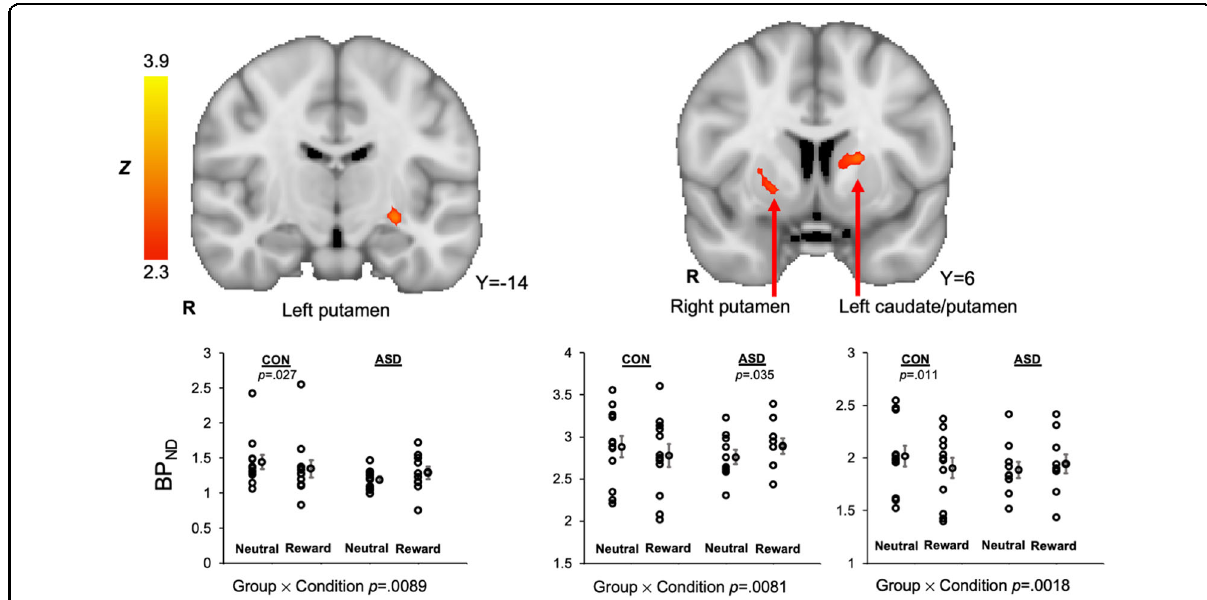
Fig. 2 Striatal clusters that showed ASD > control [ 11 C]raclopride BP ND (reward> neutral), signifying decreased phasic release of dopamine to rewards in the ASD group relative to the control group, were evident in the left putamen, right putamen, and a cluster that spanned the left caudate nucleus and putamen. For all clusters, the group (ASD, control) × condition (reward, neutral) interaction effect on [ 11 C]raclopride BP ND values were signi fi cant. For each dot plot, individual data points are displayed next to the group average with standard error bars.